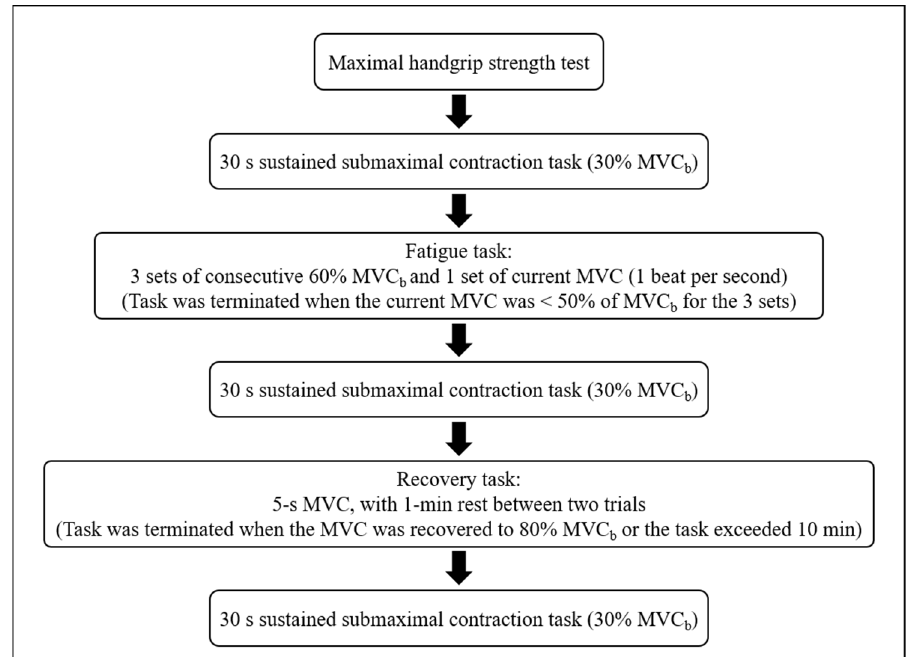
Figure 2. Experimental